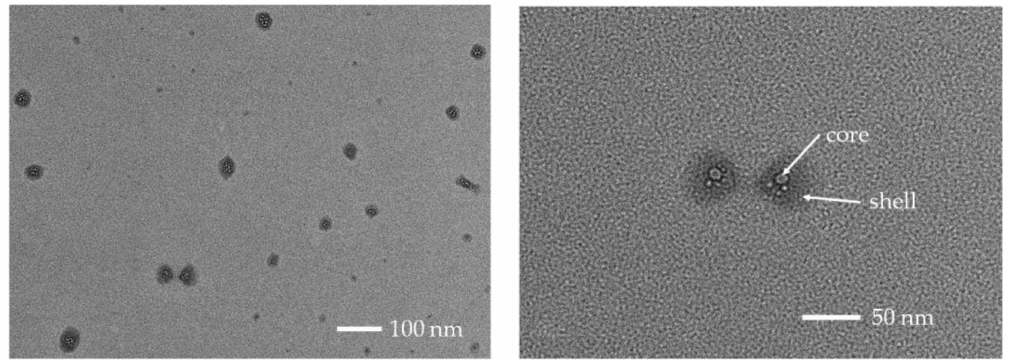
Figure 6. Transmission electron microscopy (TEM) of drug-loaded Ad-(PC 28 - b -PD 25 - b -PP 8 ) 4